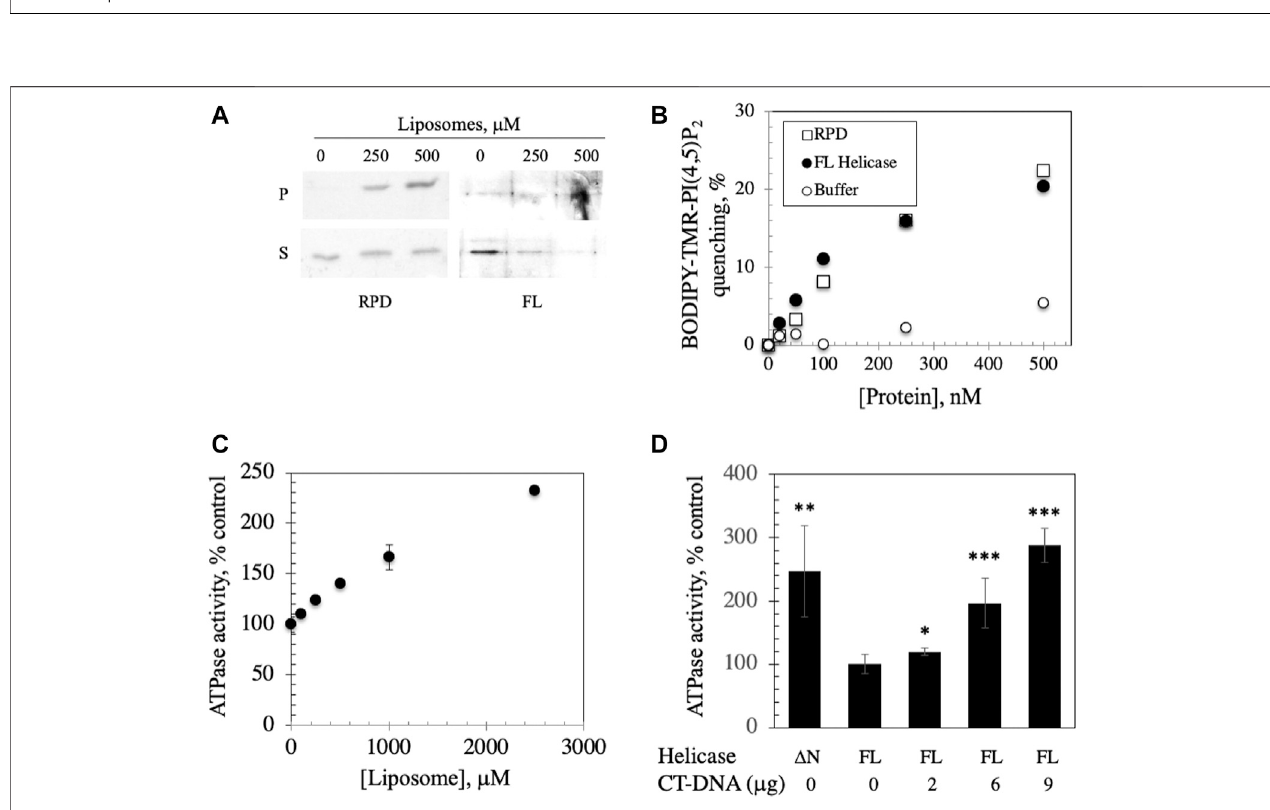
FIGURE 4 | FL helicase binds to membranes and Ipid binding enhances its ATPase activity. (A) RPD and FL helicase cosediment with increasing liposome concentrations (B) Both RPD (open squares) and FL helicase (closed circles) exhibit increased liposome fl uorescence quenching in a dose-dependent manner. Buffer controls (open circles) are shown. (C) ATPase activity of the human replicative mtDNA helicase is enhanced by binding to liposomes. Malachite green ATPase/GTPase assay was performed after incubation of2 μ g ofFL Hs helicase with increasing CL-asolectin liposome concentrationsfor 30 min at room temperature. (D) ATPase activity oftheFLhelicase isDNAdependent; CT-DNA,calf thymus DNA. Avariant lackingtheN-terminus ( Δ N)demonstrates increased activity. Theerrorbars represent the standard deviation of three independent experiments. *, p < 0.05; **, p < 0.01; ***, p < 0.001 as compared to ATPase activity in the absence of DNA.